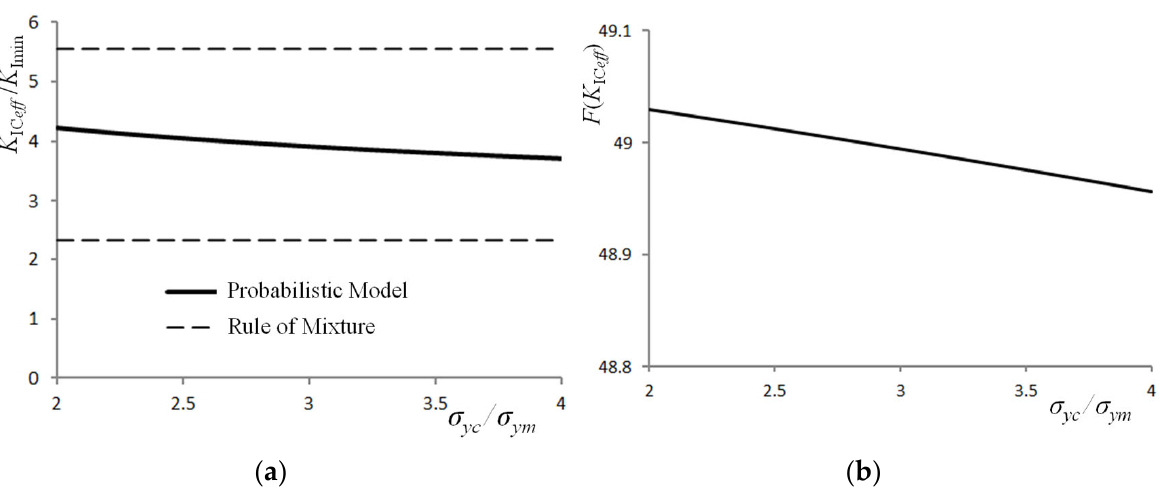
Figure 7. E ff ect of the change in the yield stress of the composite on fracture toughness ( a ) and the cumulative probability of fracture ( b ), K Ici / K Icm = 1/8, K Imin = K Ici = 5 (MPa·m 0.5 ), E c / E m = 2, E m =70 (GPa), σ ym =150 (MPa), V i = 0.35.